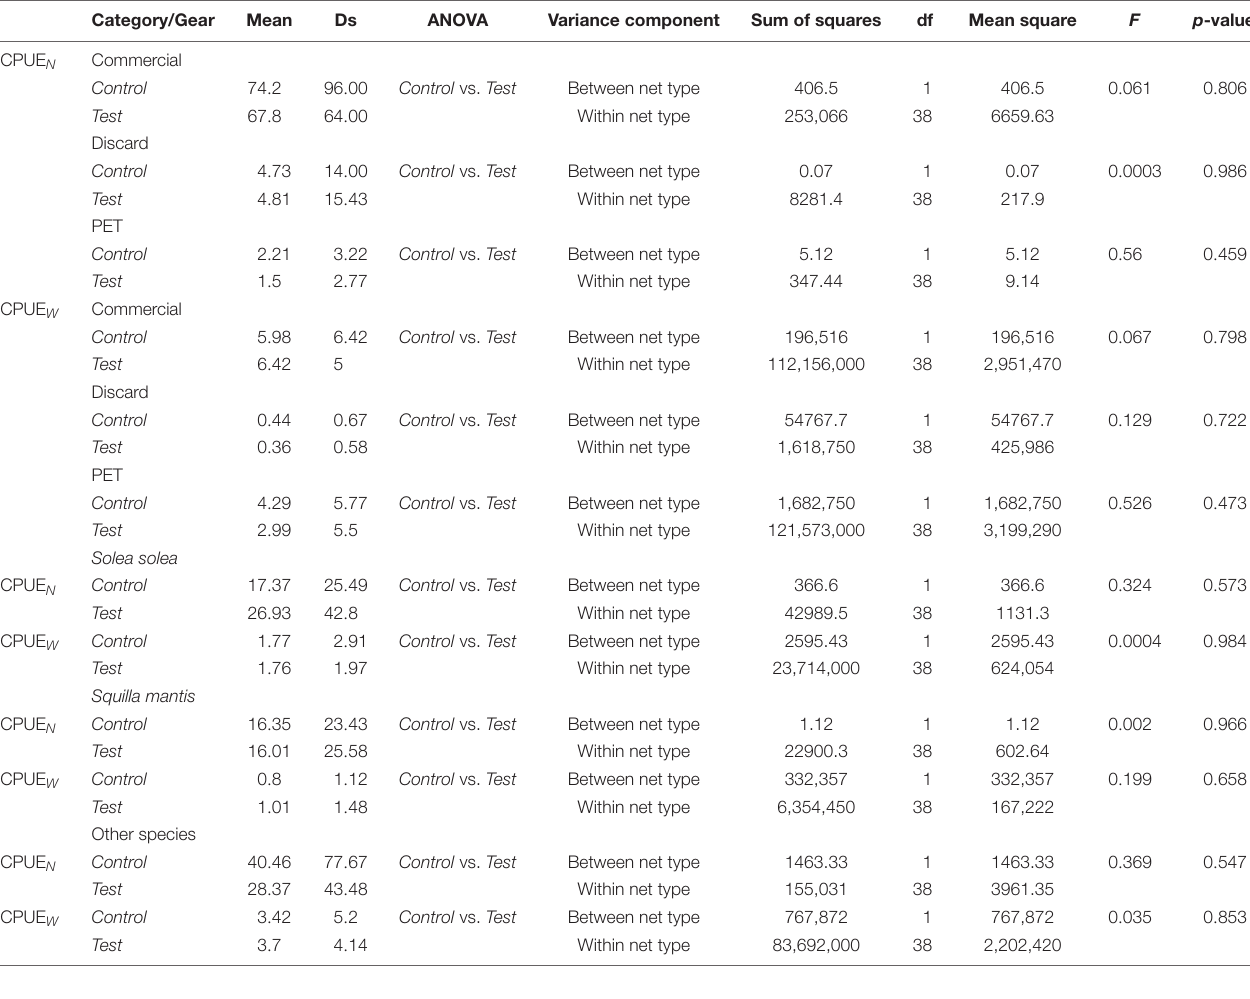
TABLE 3 | Set net catch rates expressed as mean CPUE N and CPUE W and summary of the One-way ANOVA applied to categories: Commercial, discard, PET (Protected, Endangered, and Threatened species), and target species to assess the difference between two types of nets (with and without LEDs; Control = without illumination; Test = with UV-LED lamps).